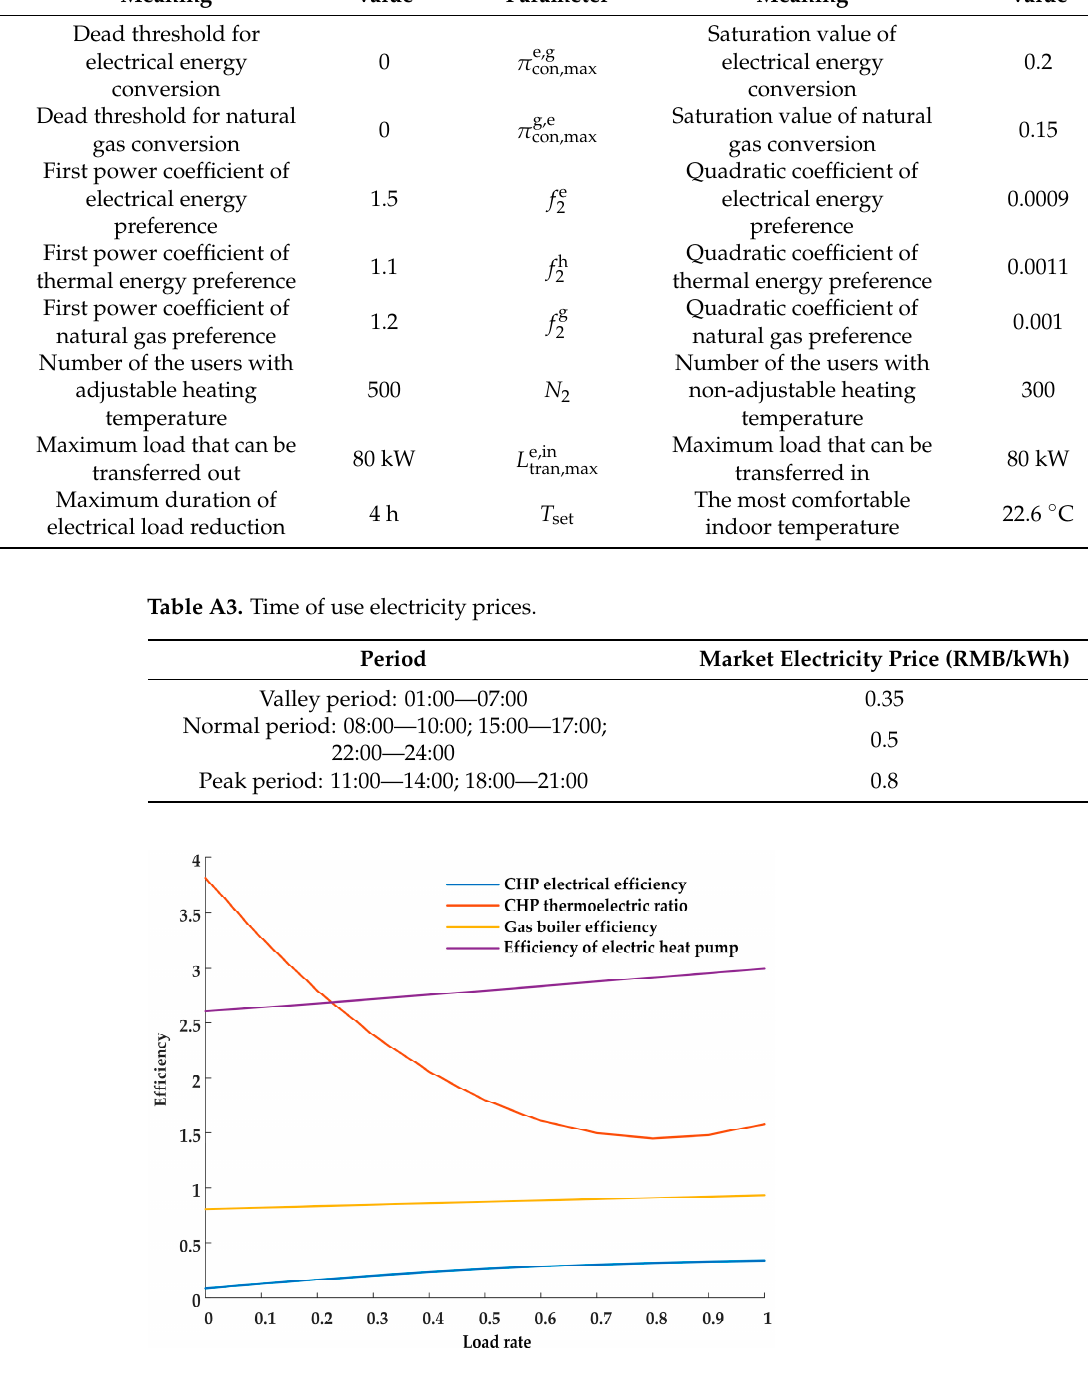
Table A2. Data parameters for users.